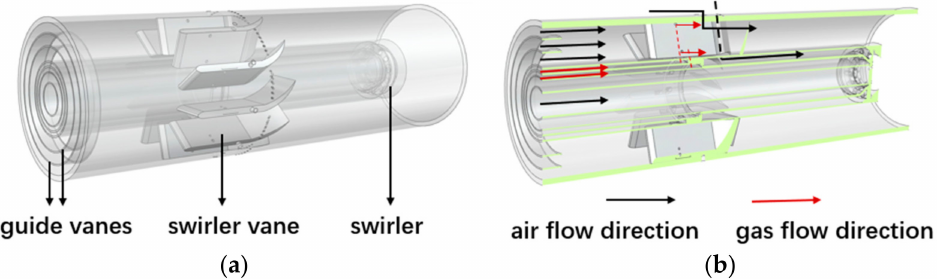
Figure 4. Single burner structure and medium flow diagram. ( a ) Burner construction; ( b ) Medium flow